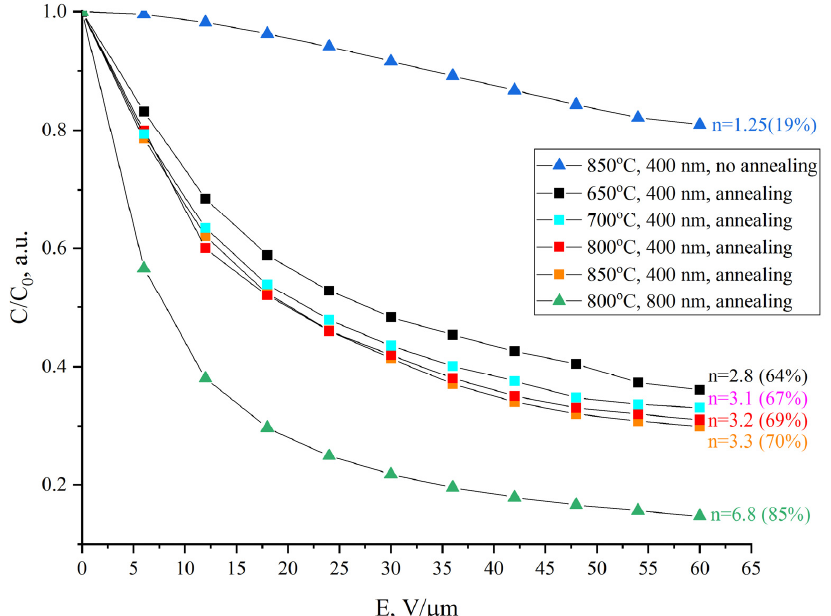
Figure 5. Dependencies of the capacitances of the BTS films based planar capacitors on control electric field strength.